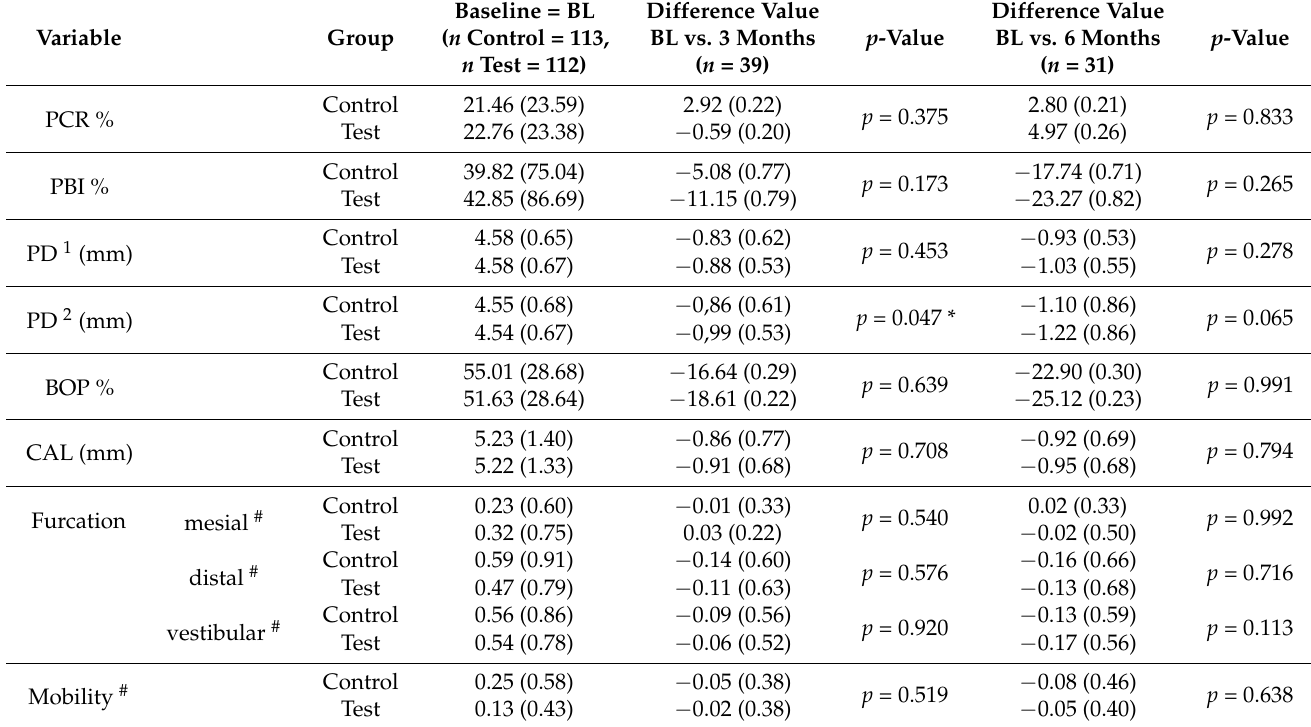
Table 2. Mean values ( ± SD) for plaque control record (PCR), papilla bleeding index (PBI), probing depth (PD), bleeding on probing (BOP), clinical attachment level (CAL), furcation, and tooth mobility (teeth 4 to 8 with PD ≥ 4 mm to ≤ 7 mm) at baseline, 3 months, and 6 months for the test group (VIS + wIRA) and the control group (hand instrumentation with Gracey